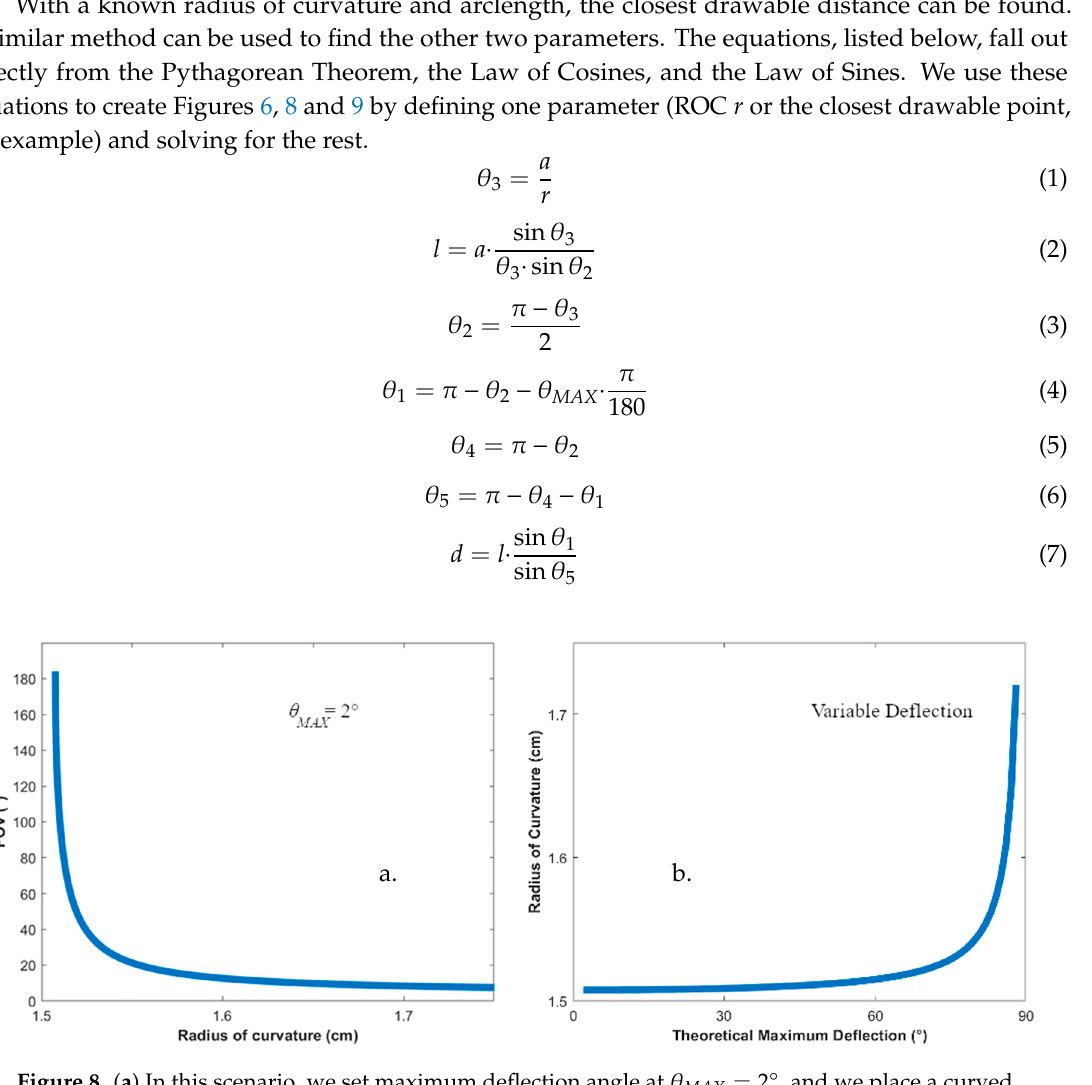
Figure 8. ( a ) In this scenario, we set maximum deflection angle at θ MAX = 2 ◦ , and we place a curved display (arbitrarily) 5 cm in front of the eye and hold that fixed position. As the radius of curvature of the display increases past the eye, the FOV rapidly decreases until it converges to the 4° flat-screen case. ( b ) Here, we hold the FOV = 180° and the distance of the eye from the device to 1.5 cm. If we allow for the possibility of an increased deflection angle in the future, we see that, even at high deflection angles, the possibility of moving the eye from the ROC center and maintaining our high FOV is minimal.